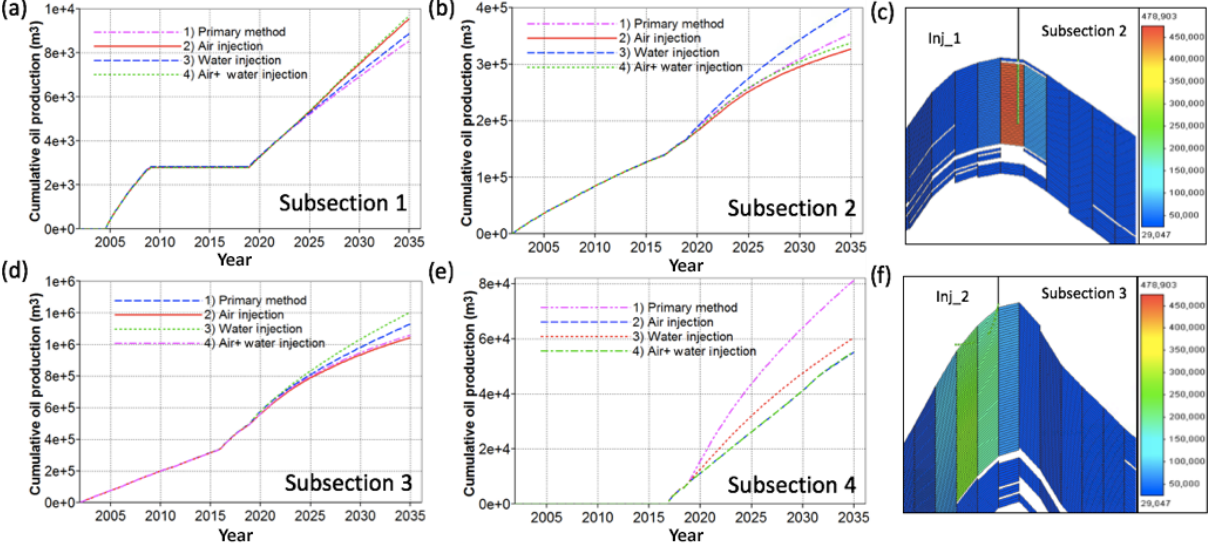
Figure 7. Cumulative oil production for 4 subsections (a, b, d, e) and temperature profiles for scenario 2 in subsections 2 (c) ; subsection 3 (f) .